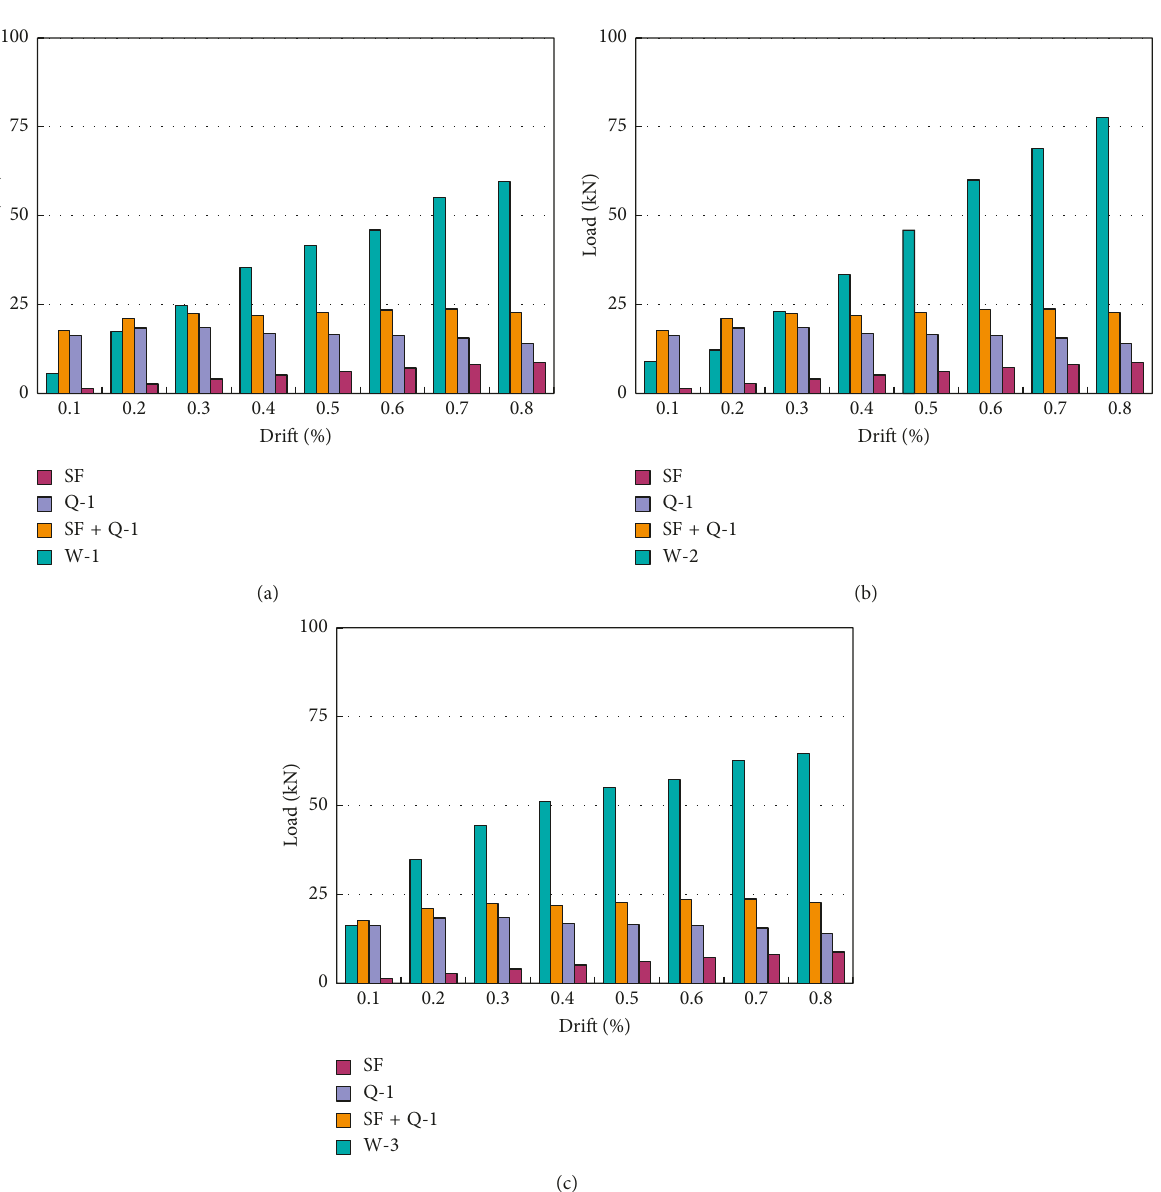
Figure 15: Comparison of load-bearing capacity at some given drift. (a) Comparison between W-1 and Q-1. (b) Comparison between W-2 and Q-1. (c) Comparison between W-3 and